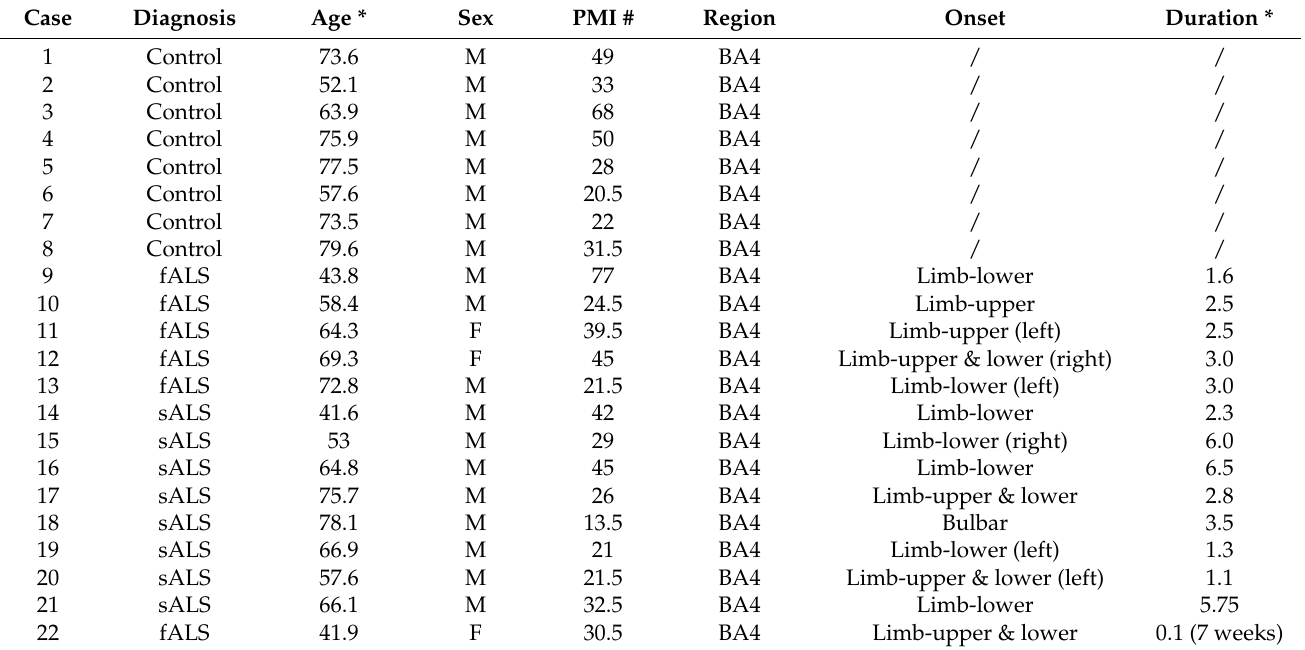
Table 1. Clinical data of human post-mortem tissue samples